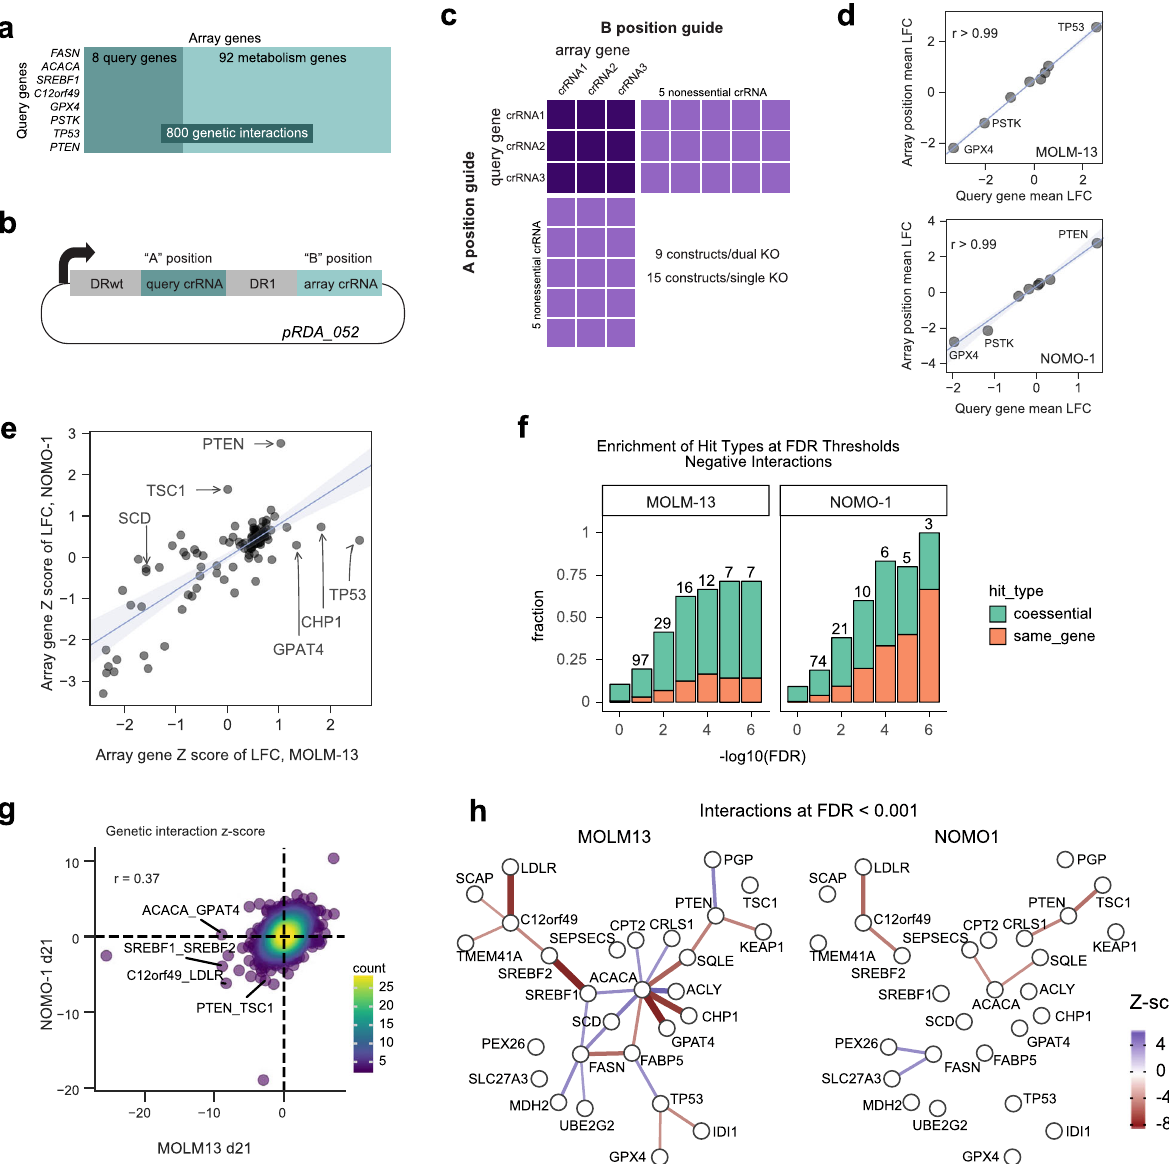
Fig. 4 Genetic interactions reveal a rewired lipid biosynthesis pathway in FASTS cells. a Genetic interaction screen targets eight query genes, selected from FASTS cluster and dPCC analysis, and 100 array genes sampling lipid metabolism pathways, for a total of 800 pairwise knockouts. b Library design uses a dual-guide enCa12a expression vector which targets the query gene in the “ A ” position and array gene in the “ B ” position. c Overall library design includes three crRNA/gene plus control crRNA targeting nonessential genes. Single-knockout constructs (target gene paired with nonessential controls) allow accurate measurement of single-knockout fi tness. d Considering single-knockout fi tness of query genes in the “ A ” and “ B ” position of the crRNA expression vector shows no position effects in the two cell lines screened (MOLM13, NOMO1). LFC log-fold change. e Single-knockout fi tness ( Z- score of mean LFC) is highly consistent between MOLM13 and NOMO1, but reveals background-speci fi c PS genes. f Enrichment among GI for coessential and self- interacting genes. Self-interactions among genes that show single-knockout fi tness phenotypes are expected, re fl ecting the quality of GI observations. g Global comparison of MOLM13, NOMO1 genetic interaction Z- scores. h Network view of interactions in each background shows rewiring in MOLM13 FASTS